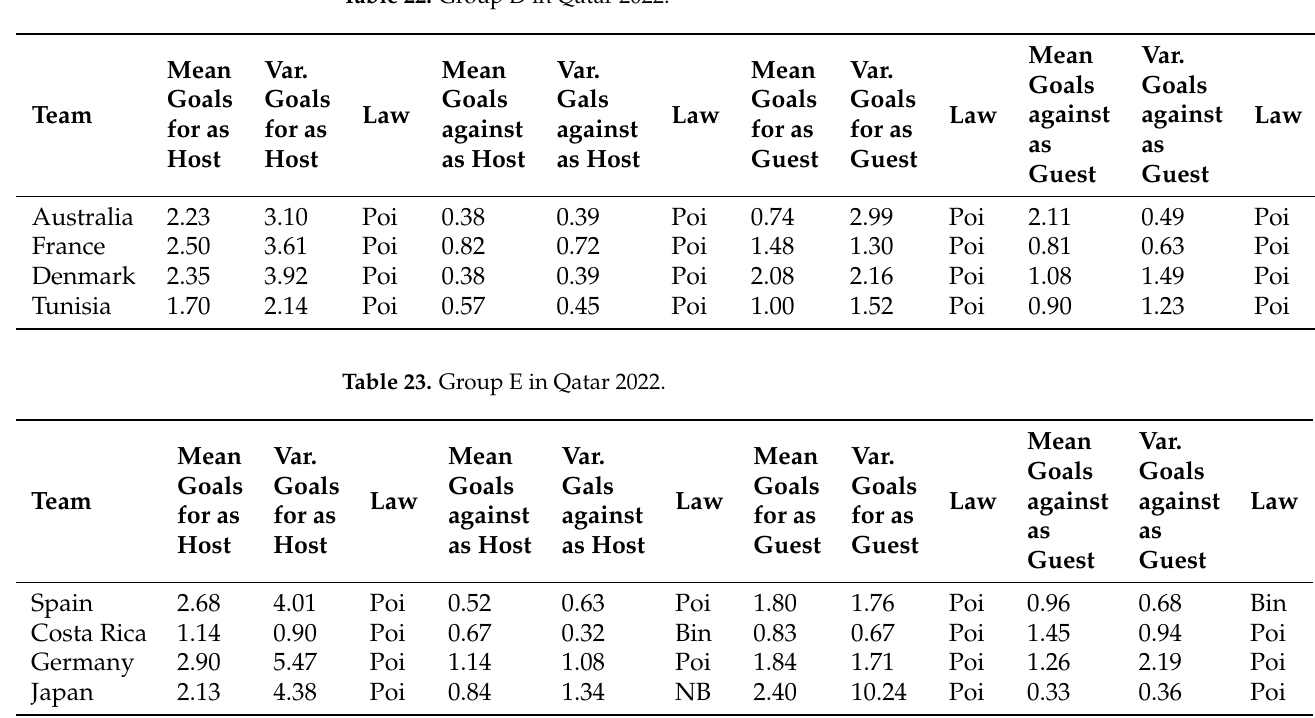
Table 22. Group D in Qatar 2022.